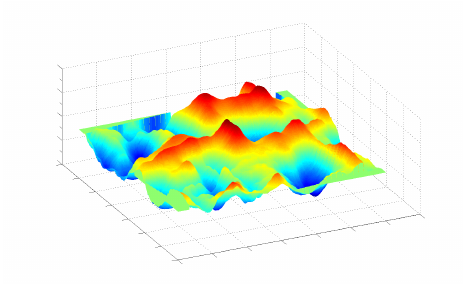
Figure 4: Typical normalized cross-correlation result between the sensed image and reference image. The distribution represents the likelihood of the measurement observation used to update the PMF.